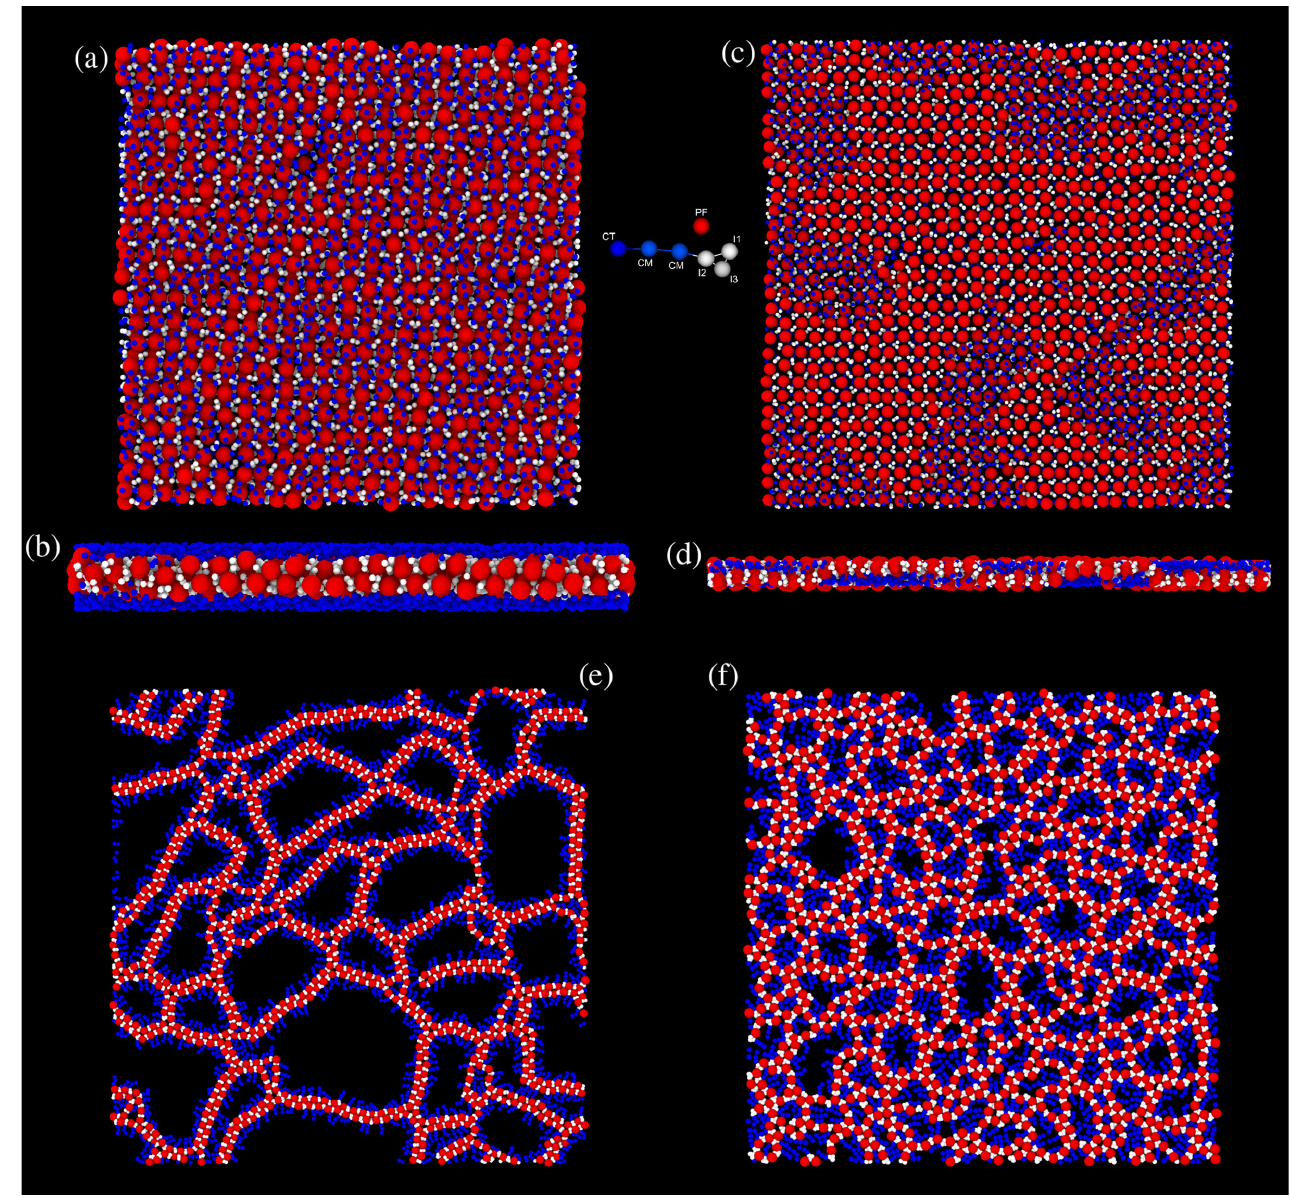
FIG. 4. Typical systems snapshots at chosen l . We show typical configurations of the system in different conditions of confinement, p at T ¼ 400 K. Colors are the same as in the IL model shown in the same figure, and beads nomenclature can be found in the Methods section. Note that we have exaggerated the size of the (red) anions beads, to underline the symmetry of the ordered phases. (a),(b) Top 23 Å. (c),(d) Top and side view for l 13 Å. In (e), we show a typical gel-like configuration at l 7 Å and side view for l p ¼ p ¼ p ¼ 5 Å, shown in modifying into a more homogeneous configuration in extreme confinement conditions at l p ¼